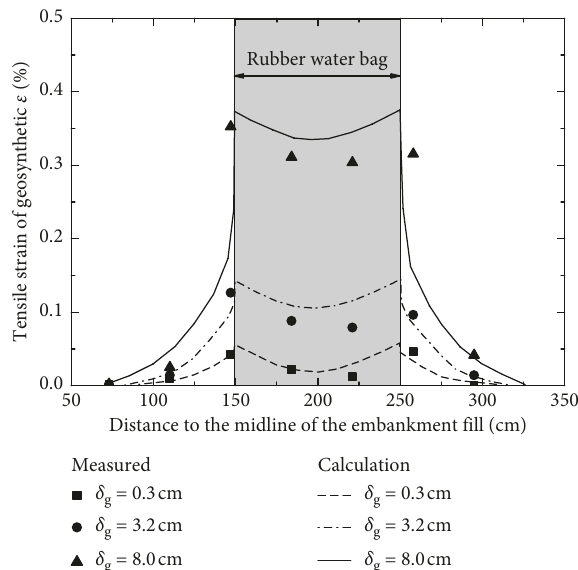
Figure 14: Comparison of tensile strains and calculated results of the Miao et al.’s